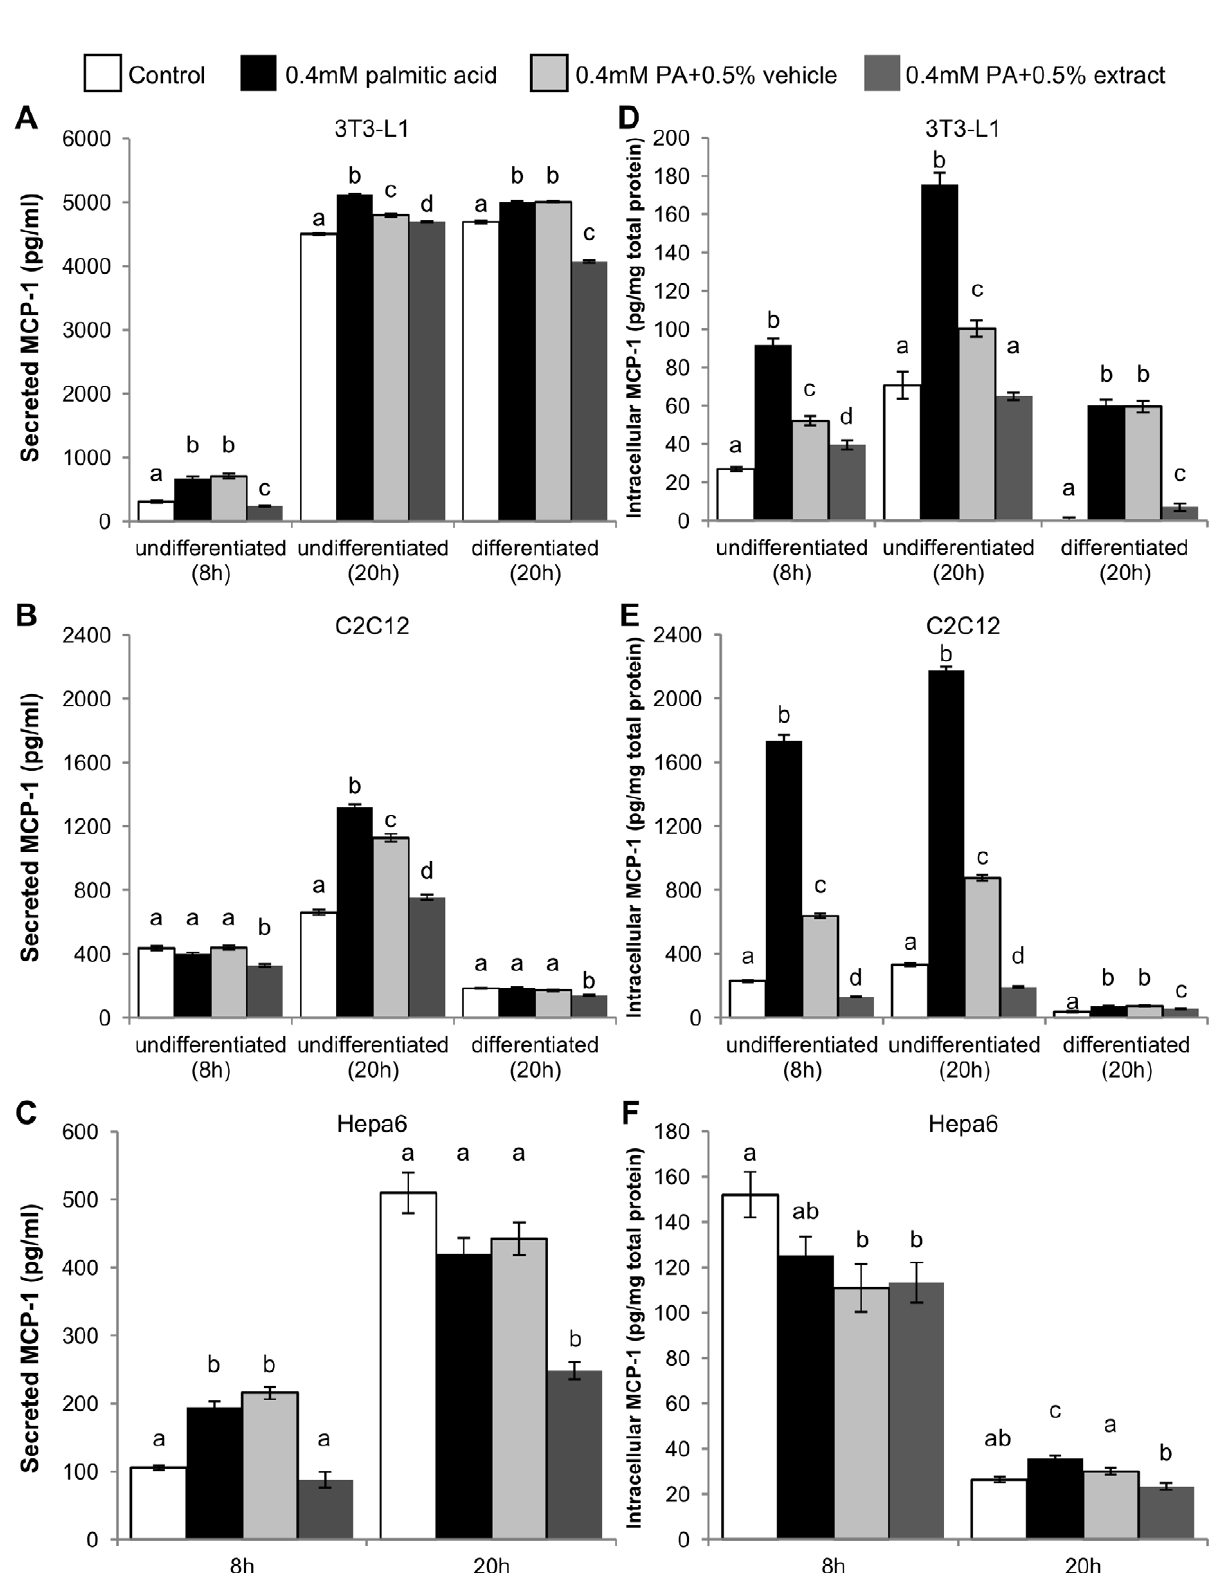
Figure 3. Effect of BEX on lipotoxic MCP-1 production. Production of MCP-1 was measured in the cell media supernatant (A–C) and cytosolic fraction (D–F) of 3T3-L1 (A, D), C2C12 (B, E), and Hepa6 (C, F) murine cells treated with palmitic acid (PA, 0.4 mM) in combination with BEX (125 m g/ml or 0.5%, v/v) or ethanol vehicle (0.5%, v/v). Concentrations were determined by cytometric bead array immunodetection against a reconstituted MCP- 1 standard. Mean 6 standard error over 3 trials, n $ 300 beads in any trial. Mean results were compared between treatments of the same cell type and